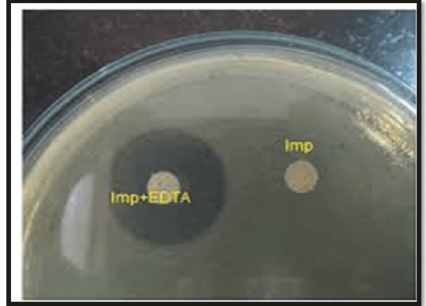
Figure 2: Disc potentiation test for detection of MBL using imipenem and imipenem-EDTA